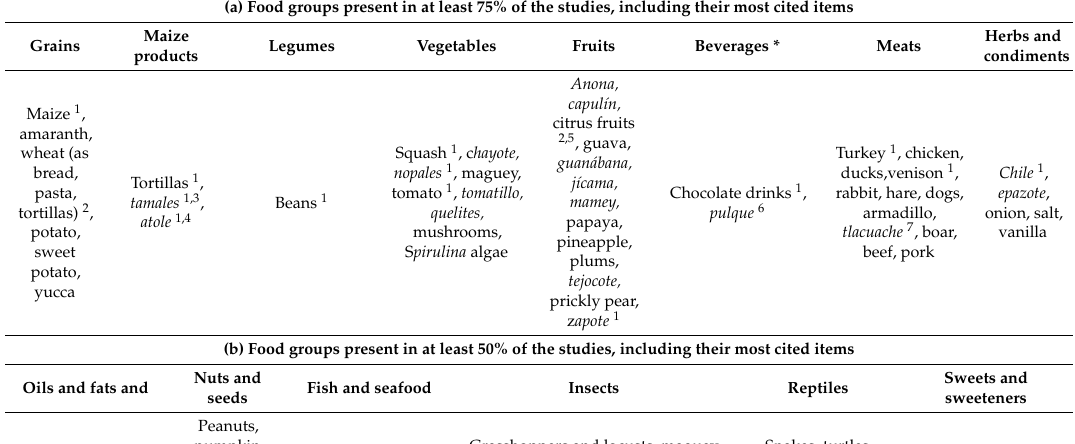
Table 3. Most cited items and food groups present in literature reviews. (n = 43)